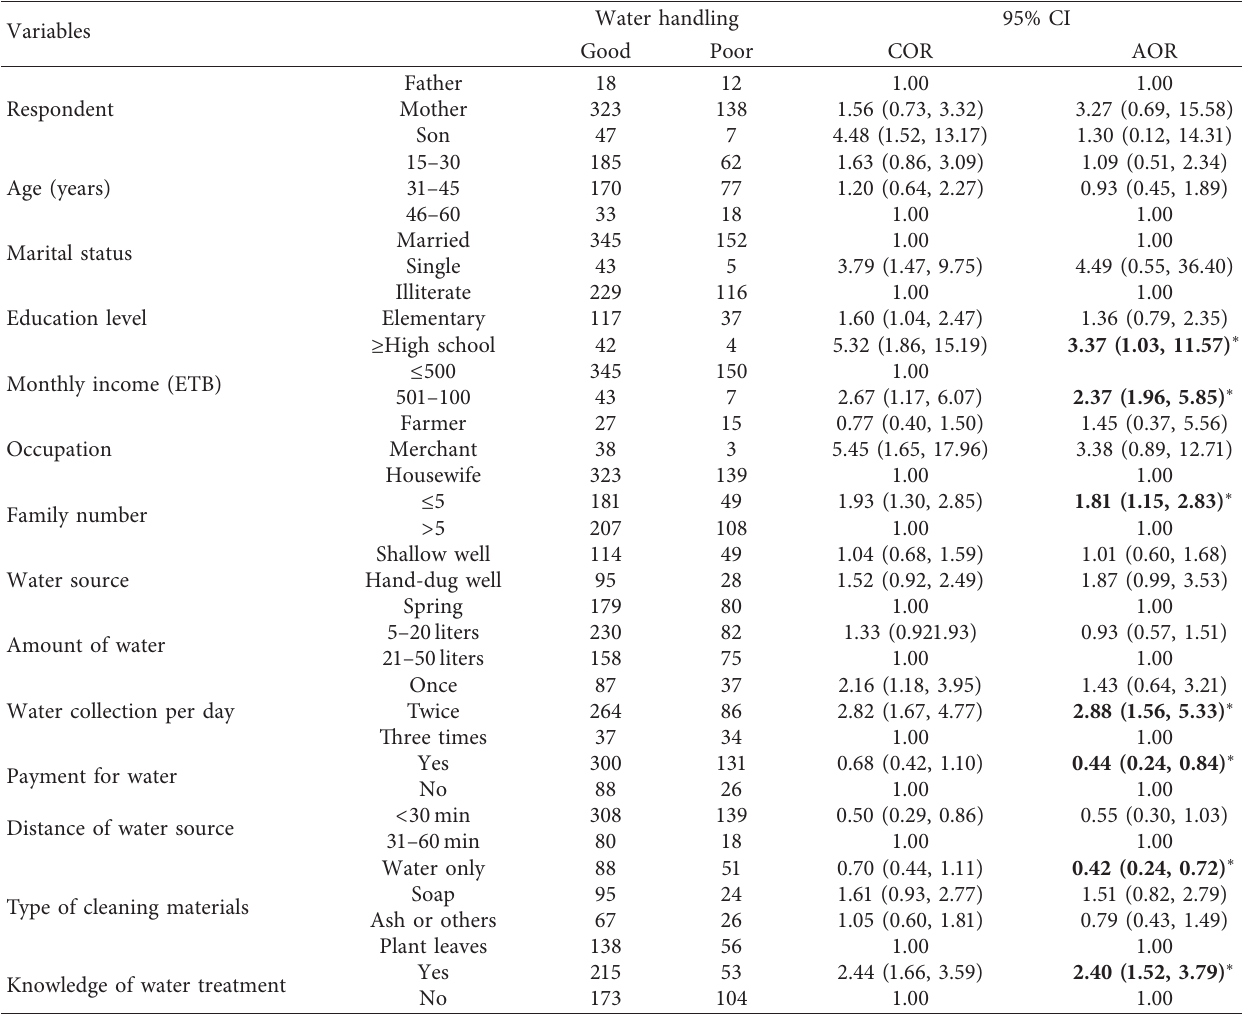
Table 6: Factors associated with water handling practice in Boloso Sore woreda, Wolaita zone, SNNPR, Ethiopia, February 2019.